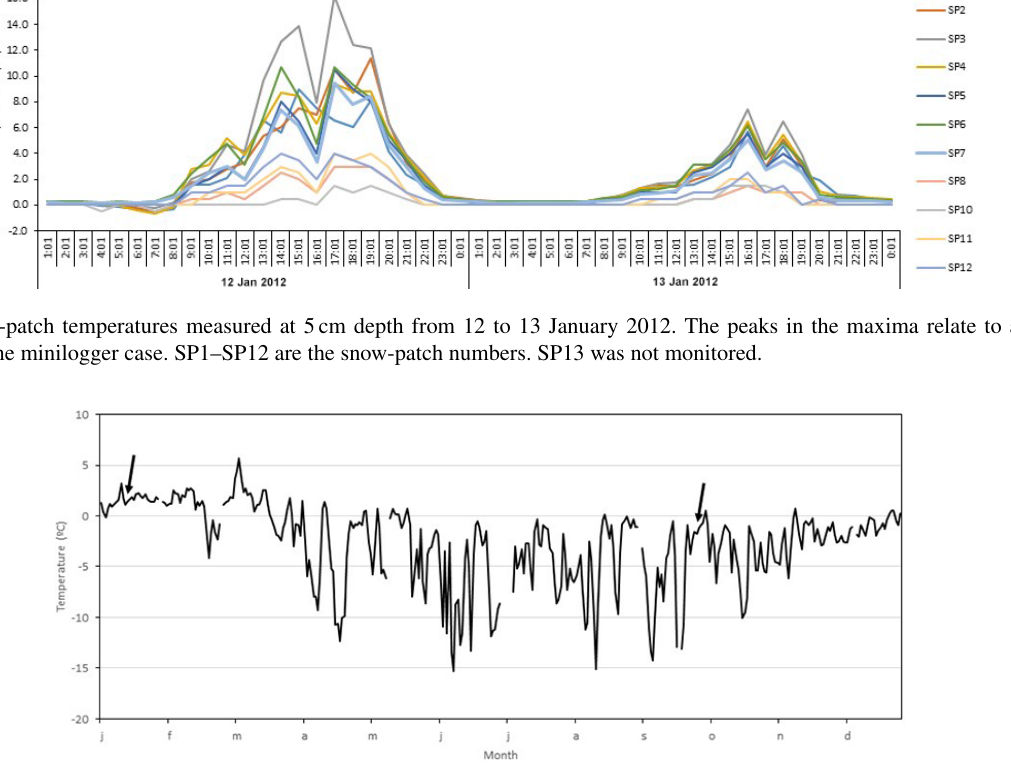
Figure 8. Mean daily air temperatures in 2012 in the Bellingshausen Station (NNDC/NCDC – NOAA). Arrows indicate the day with image